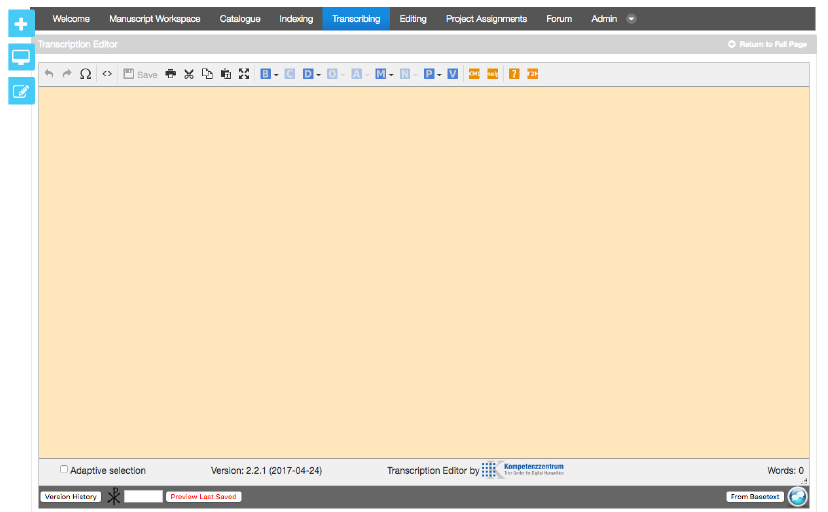
Figure 4. Transcription